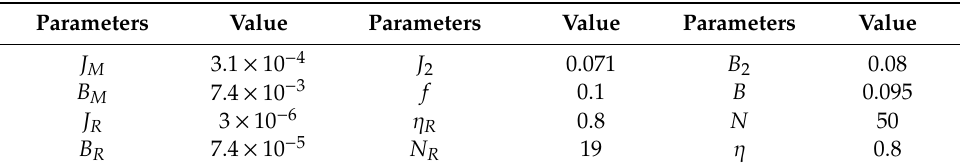
(b) Figure 19. Real-time dynamic stiffness tracking curve. ( a ) The expected joint stiffness is a sine wave signal. ( b ) The expected joint stiffness is a random signal. During the tracking control of dynamic stiffness, the joint passive deflection angle is also changing in real time due to the change of joint stiffness, as shown in Figure 20. Whether it is tracking a sine wave expected stiffness signal or a random expected stiffness signal, the change in passive